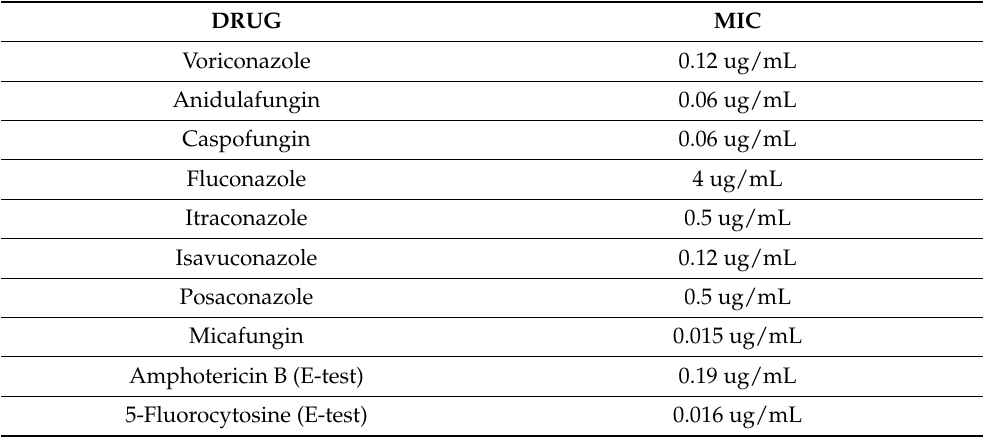
Table 1. MICs for the isolated C. glabrata